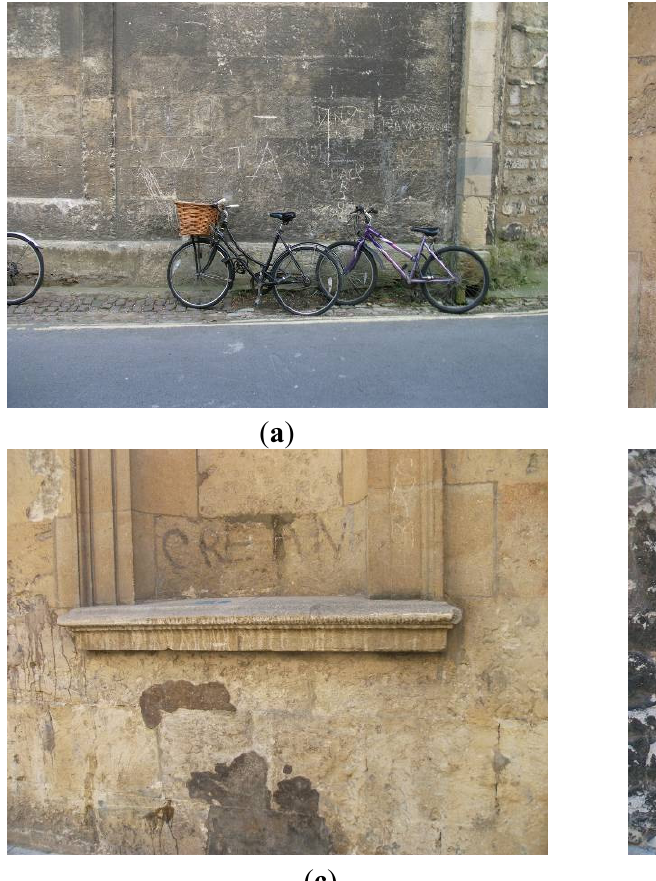
Figure 7. Evidence of human impacts on stone-work, including various examples of graffiti ( a – d